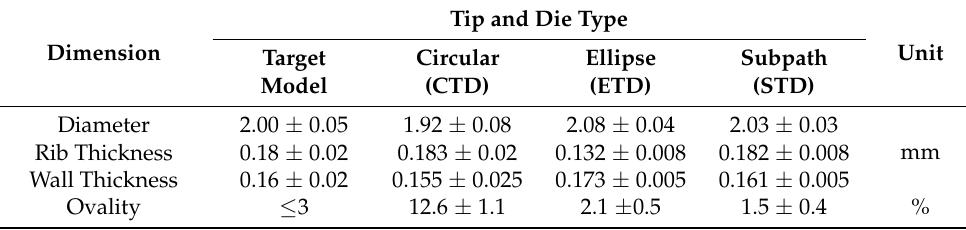
Figure 8. Comparison of multi-lumen tubes produced under same process conditions (pulling speed: 12 m/min): ( a ) CTD; ( b ) ETD; and ( c ) STD. Table 5. Dimensional specifications of multi lumen tubes made by different tip and die models.